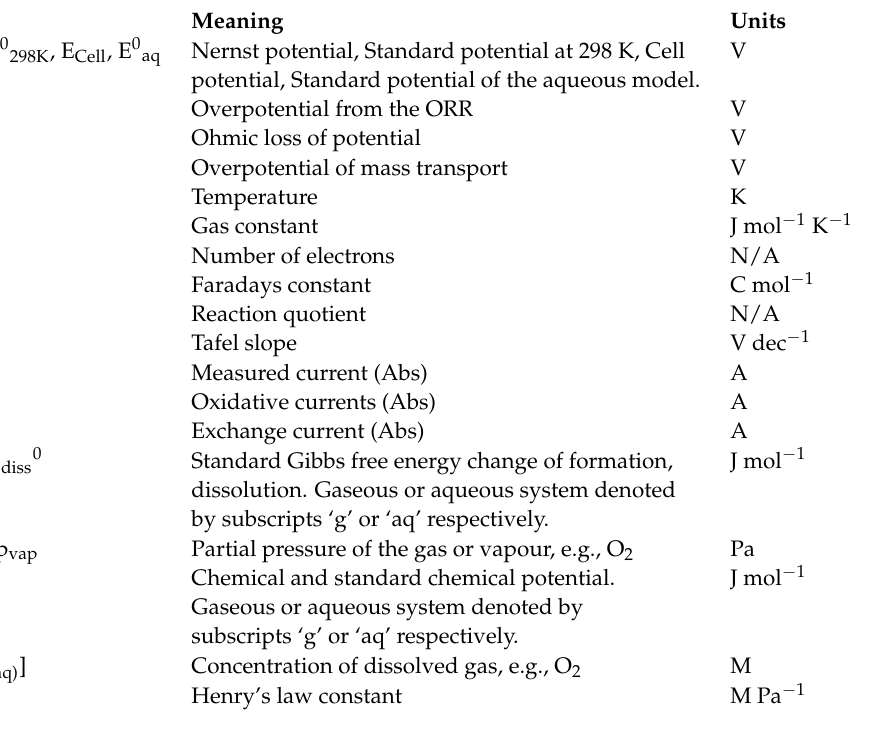
samples. Figure S4: The Tafel slope measured for all ex-situ GDE samples vs. Pt surface area. Figure S5: The exchange current density normalised to Pt surface area vs. Pt surface area. Figure S6: An example polarisation performance curve before and after H2 crossover and internal resistance corrections. Figure S7: Measured H2 crossover current vs. Pt surface area at the anode. Figure S8: A comparison of the measured and calculated (by Tafel analysis) crossover currents for the MEAs at all relative